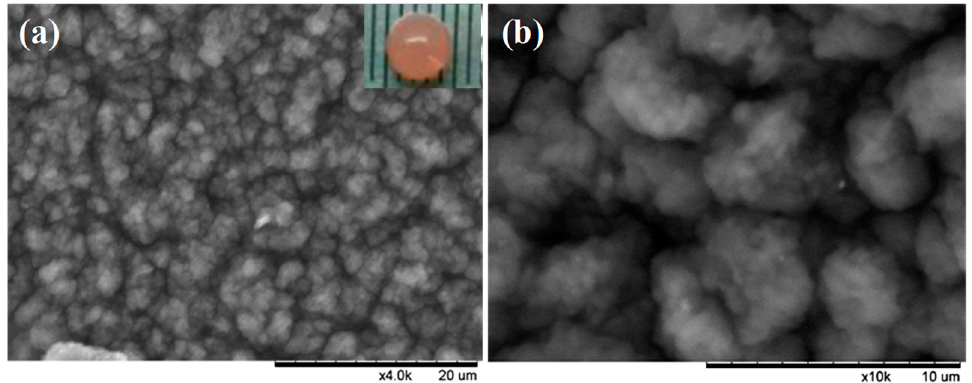
Figure 4. SEM images and photograph of the PSB-encapsulated hydrogel macrosphere.